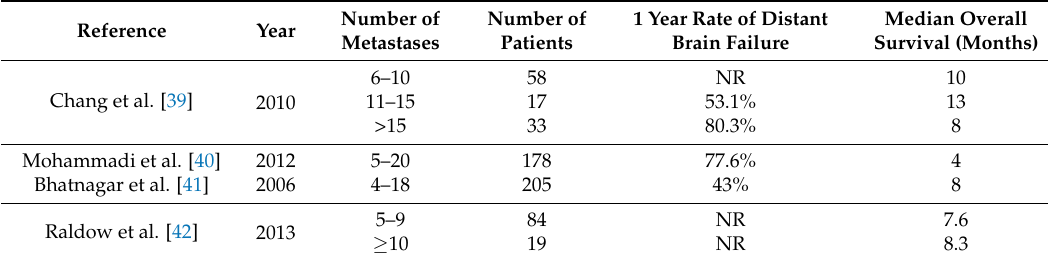
Table 1. Retrospective series of patients with more than 4 metastases treated with